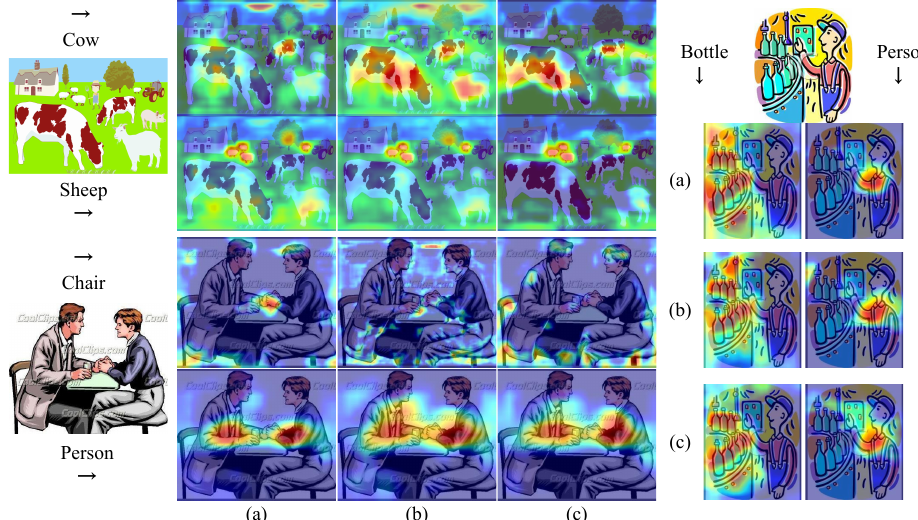
Figure 7. Visualization of the localization ability of multi-label classification. ( a – c ) are heat maps of attention for the FA branch only, FS branch only, and Proposed Method,